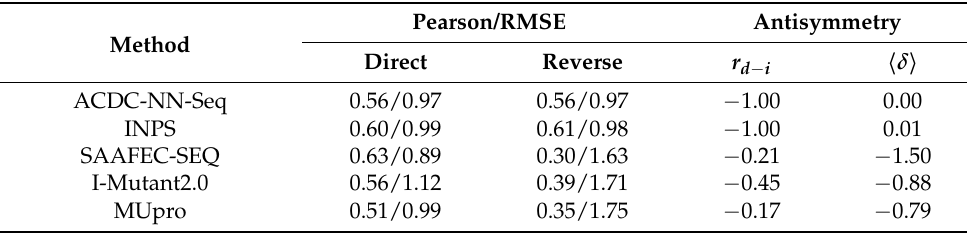
Table 5. Results on myoglobin: Comparison on myoglobin. The INPS, SAAFEC-SEQ and I- mutant2.0 results were obtained using their stand alone code, those of MUpro were obtained using the webserver available.